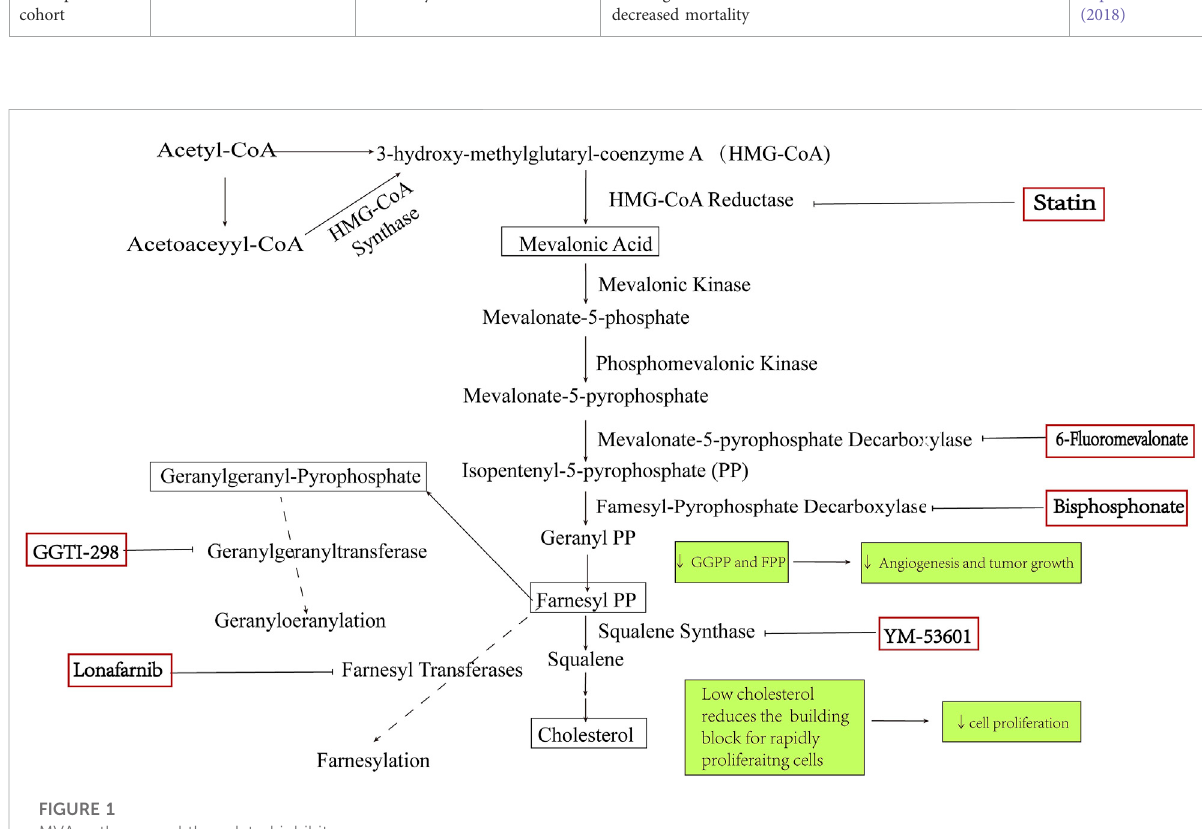
FIGURE 1 MVA pathway and the related